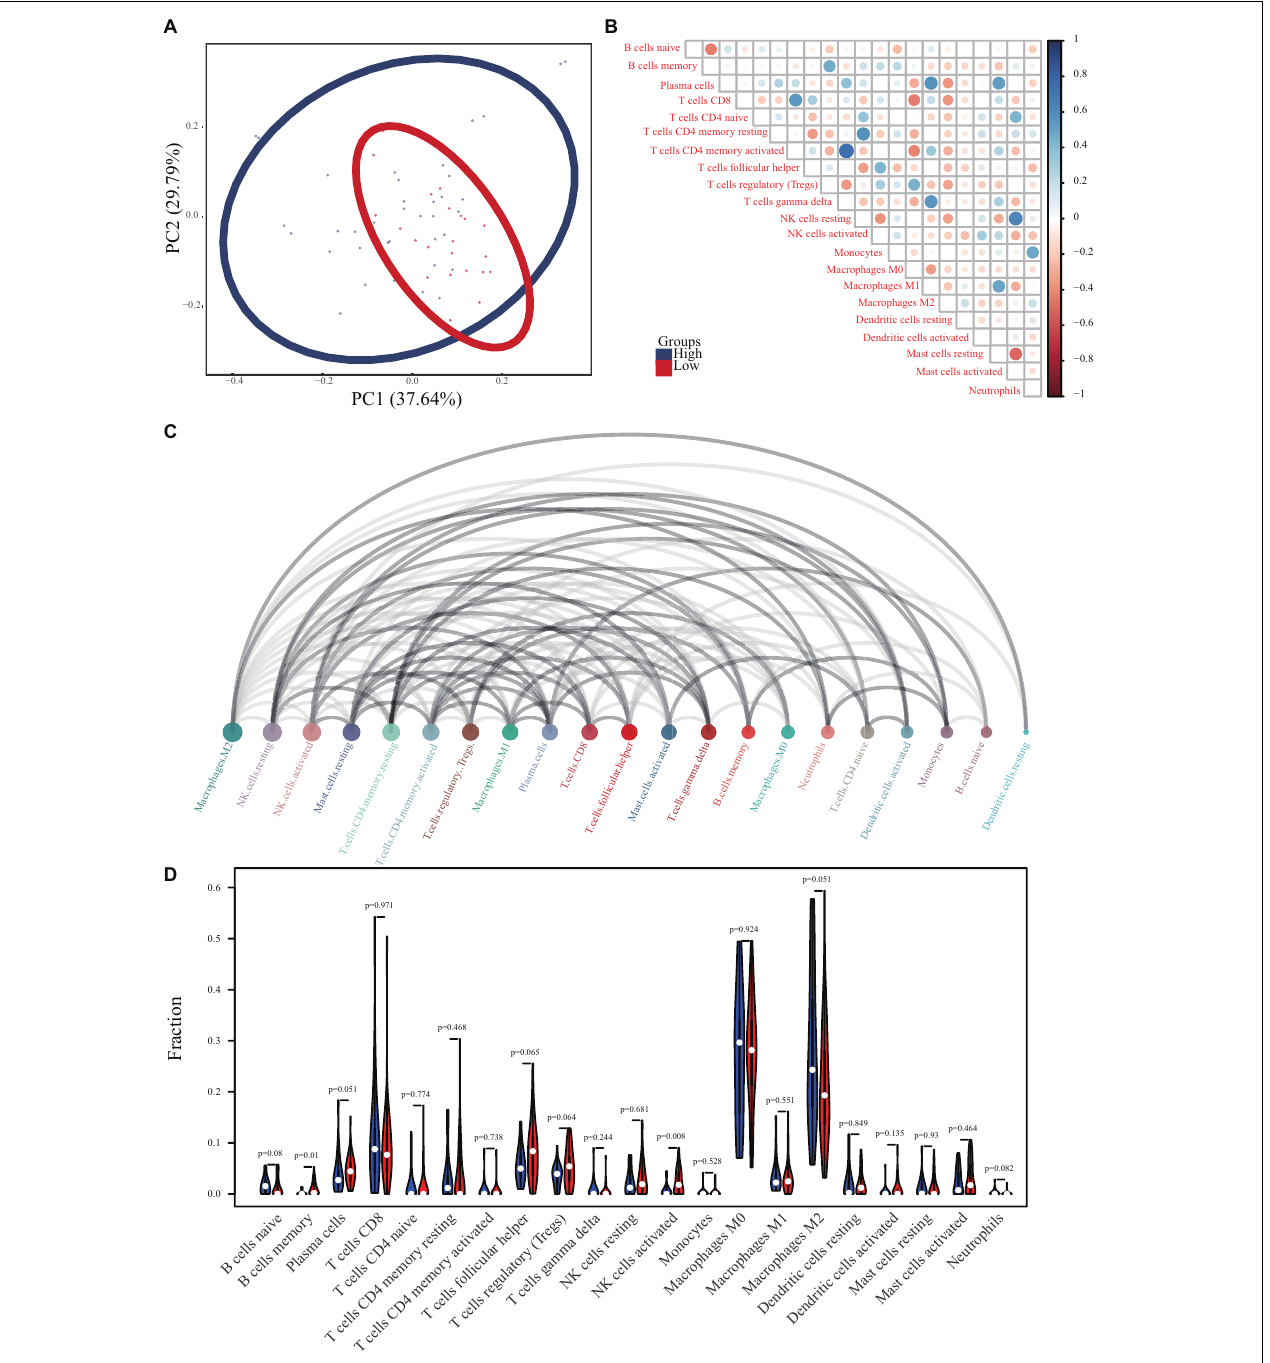
FIGURE 8 | Immune cell infiltration in ES. (A) PCA analysis of immune cell infiltration in ES samples and healthy skeletal muscle samples. (B) Correlation heat maps of 22 immune cell types. The size of each colored circle represents the related p -value; the color represents the strength of the correlation (blue and red indicate positive and negative correlations, respectively, with darker colors indicating stronger correlations). (C) Interaction network between 22 immune cell types. The circle size represents the strength of the interaction. (D) Violin chart showing differences in the infiltration of 22 immune cell types in the ES and healthy skeletal muscle groups.